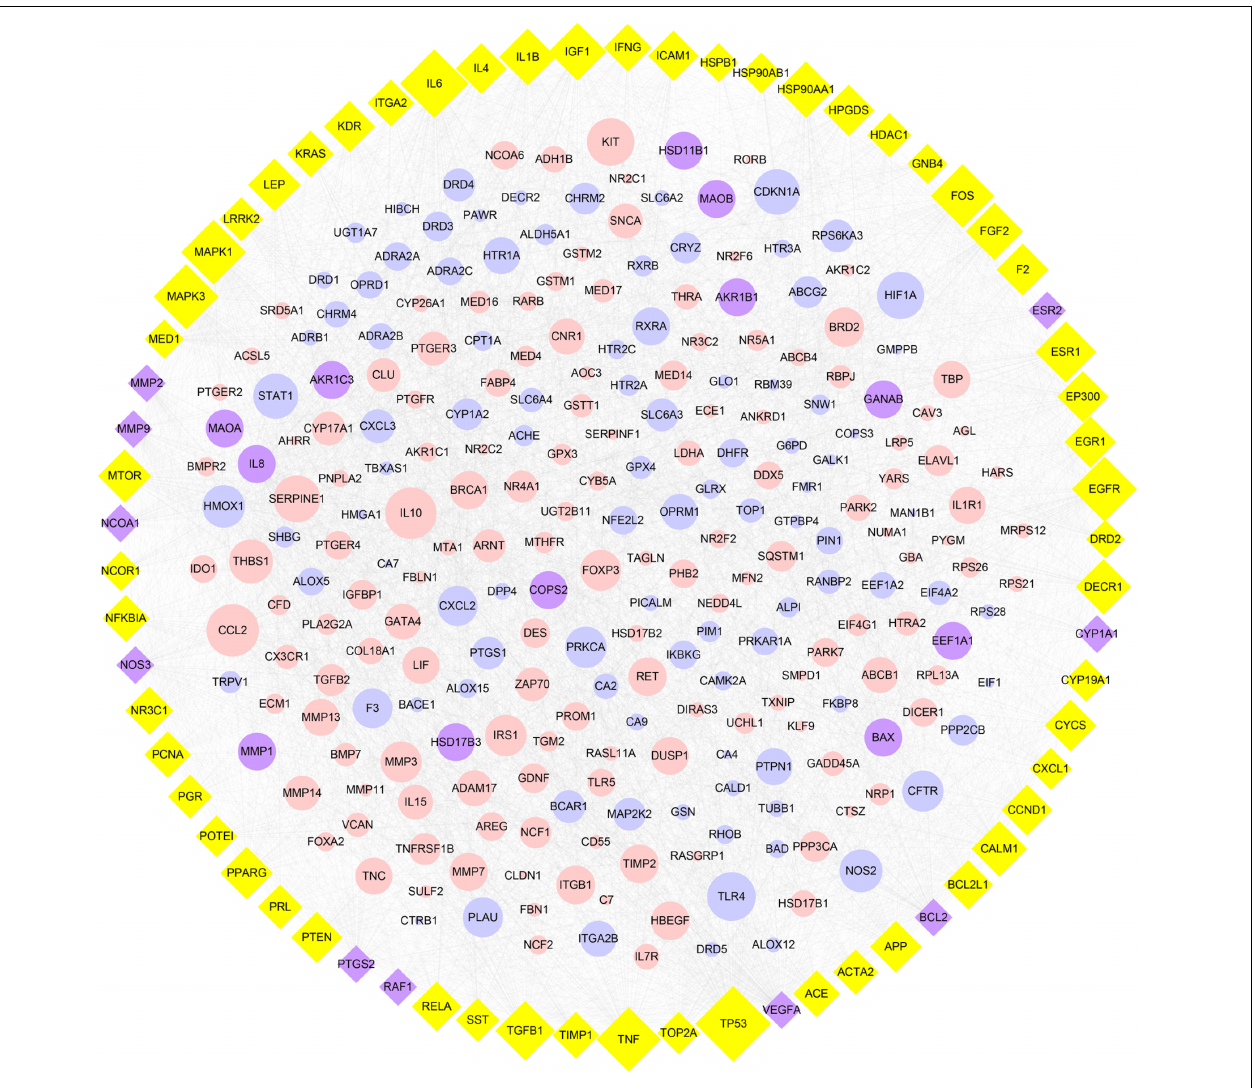
FIGURE 3 | The core protein–protein interaction network. Pink circles, blue circles, Purple circles and yellow diamonds showed for the targets of disease, targets of compounds, 22 common targets, and 66 candidate targets, respectively. Purple diamonds represented the intersection between 66 candidate targets and 22 common targets. The size of circles and diamonds indicated nodes degree